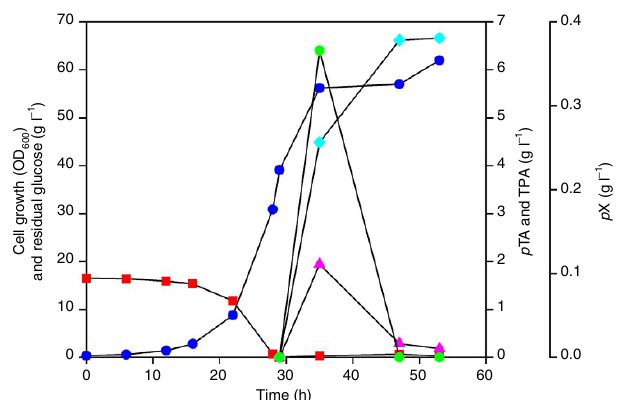
Figure 4 | Two-phase partitioning DO-stat fed-batch fermentation profile of E. coli DH5 a harbouring Piii for TPA production from 10g of p X. Time profiles of cell growth, residual glucose, p X, TPA and p TA are shown. Blue circle, cell growth (OD 600 ); red rectangle, residual glucose concentration (gl (cid:2) 1 ); pink triangle, p TA concentration; light blue diamond, TPA concentration (gl (cid:2) 1 ); green circle, residual p X concentration (gl (cid:2) 1 ) in